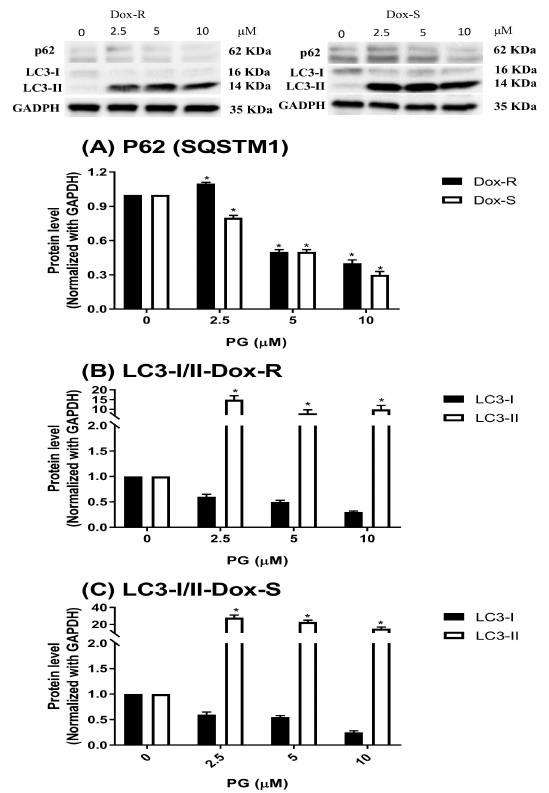
Figure 3. Alteration of autophagic marker levels in Dox-R and Dox-S cells after PG treatment. Protein levels of ( A ) p62 (SQSTM1), LC3-I/II in ( B ) Dox-R and ( C ) Dox-S were analyzed after PG treatment by Western blotting. Protein levels were represented as mean ± SD from 3 independent glyceraldehyde 3-phosphate dehydrogenase (GAPDH)-normalized chemiluminescent experiments. *, p < 0.05 compared with untreated